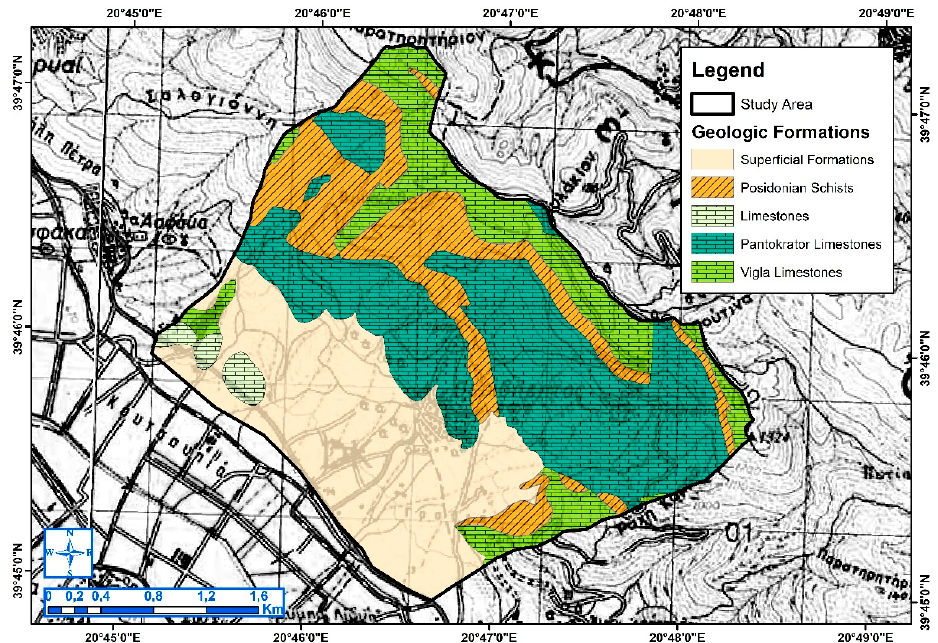
Figure 3. Geological map of the study area (based on the Institute of Geology and Mineral Exploration (IGME) [45]).